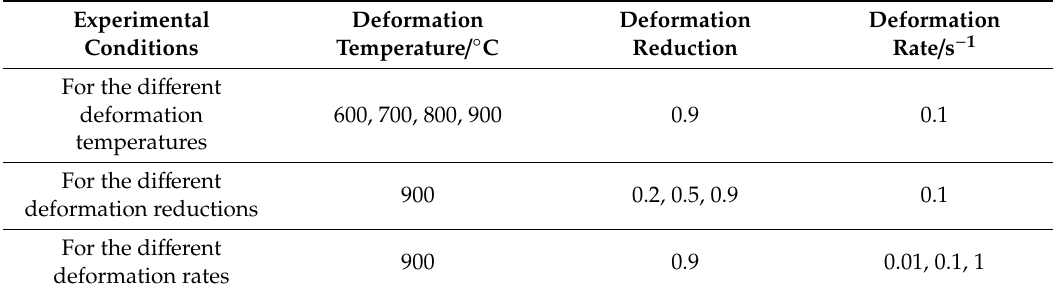
Figure 2. Schematic illustration of the di ff erent process parameters: ( a ) the di ff erent deformation temperatures, ( b ) the di ff erent deformation reductions, ( c ) the di ff erent deformation rates. Table 2. The process parameters of the samples for the di ff erent conditions.